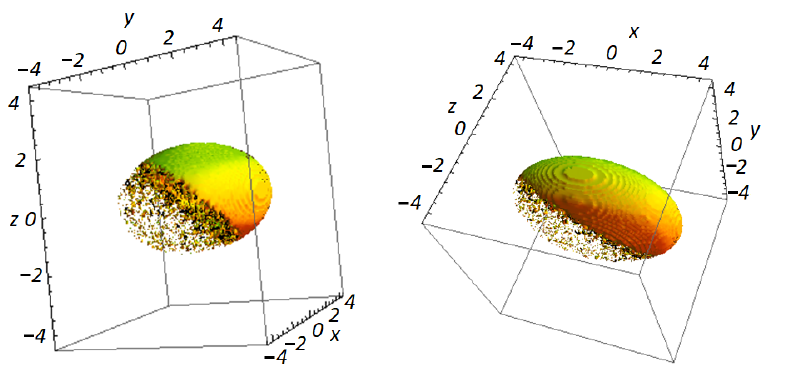
+ y 2 + z 2 = 1, for one specific incidence 9 16 4